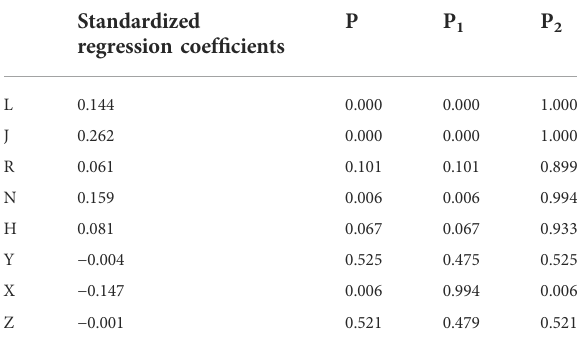
TABLE 9 Regression analysis of the factors in fl uencing the spatial correlation of carbon emission ef fi ciency in China ’ s logistics